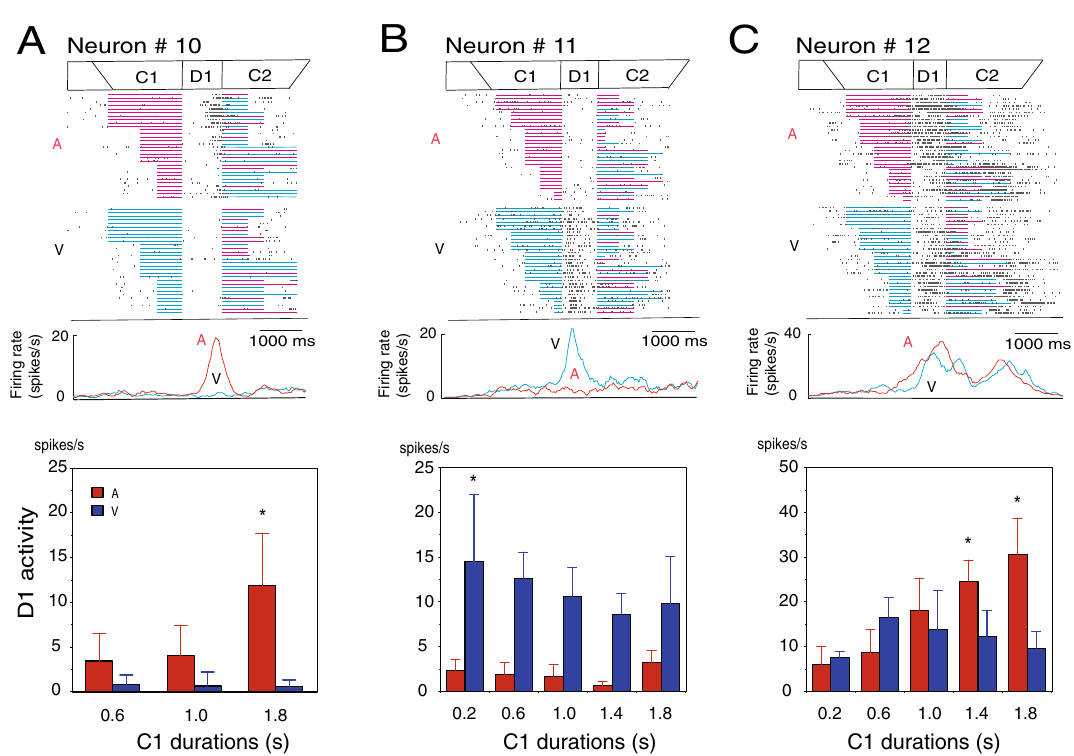
Figure 5. Activity of D1-responsive neurons. ( A ) A D1-responsive neuron exhibiting D1 activity only after auditory C1. A raster diagram and firing rate curves are aligned with D1 onset. The raster display is separately shown in auditory (A) and visual (V) C1 trials and is rearranged by the C1 duration from long to short. Firing rate curves show changes in activity for the auditory (A, red) and visual (V, blue) C1 trials. A bar graph (bottom) shows mean firing rates during the D1 period to each C1 duration in the auditory (red) and visual (blue) C1 trials for this neuron. The activity in the trials with a C1 duration of 1.8-s was greater than that in other types of trials (shown by *). ( B ) A D1-responsive neuron showing D1 activity only after visual C1. The activity in the trials with a C1 duration of 0.2-s was greater than that in other types of trials (shown by *). ( C ) A D1-responsive neuron showing D1 activity following auditory and the visual C1. The activity in the trials with auditory C1 durations of 1.4- and 1.8-s was greater than that in other types of trials (shown by *).